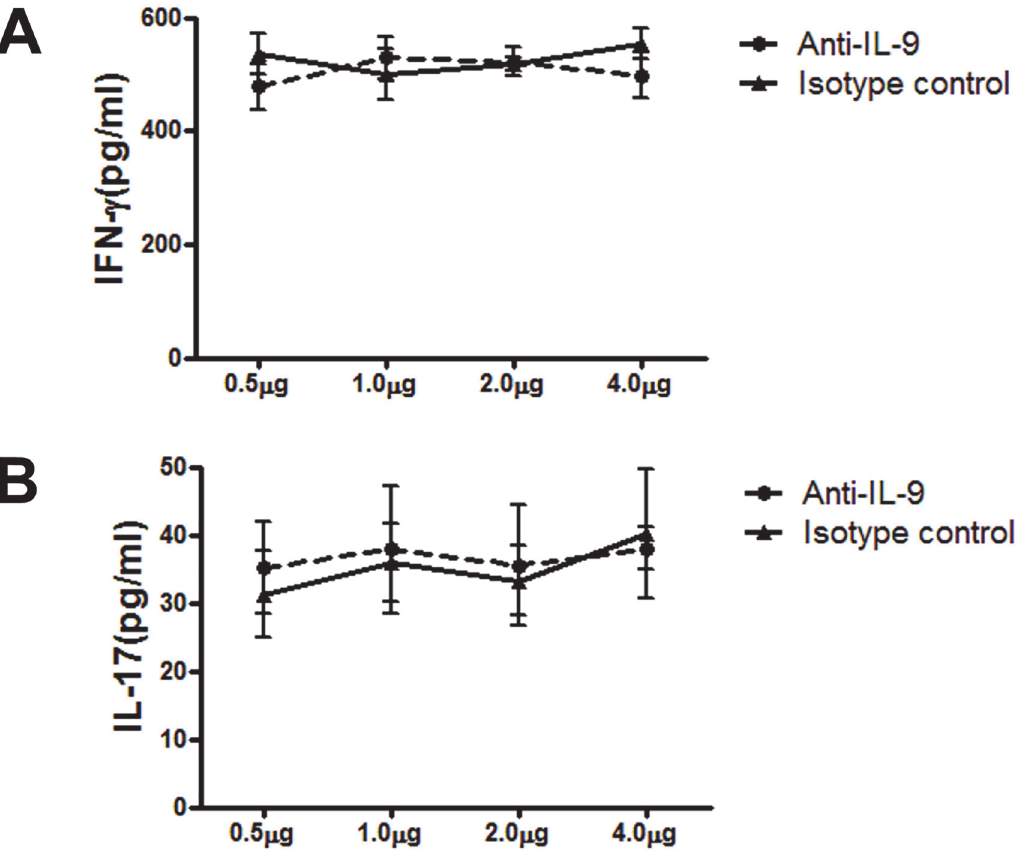
Fig 3. Blockade of endogenous IL-9 had no significant effect on IFN- γ and IL-17 production by ex vivo spleens isolated from Cm infected mice. Spleen cells from mice infected with Cm at day 3 post-infection were cultured in 48-well plates with UV-inactivated-Cm stimulation in the presence of anti- mouse IL-9 mAb or isotype control at various concentrations as indicated. The culture was proceeded for 72 hours and the concentration of IFN- γ and IL-17 in culture supernatants was determined by ELISA. One representative experiment of three independent experiments is shown. The results are shown as mean ± SD of each